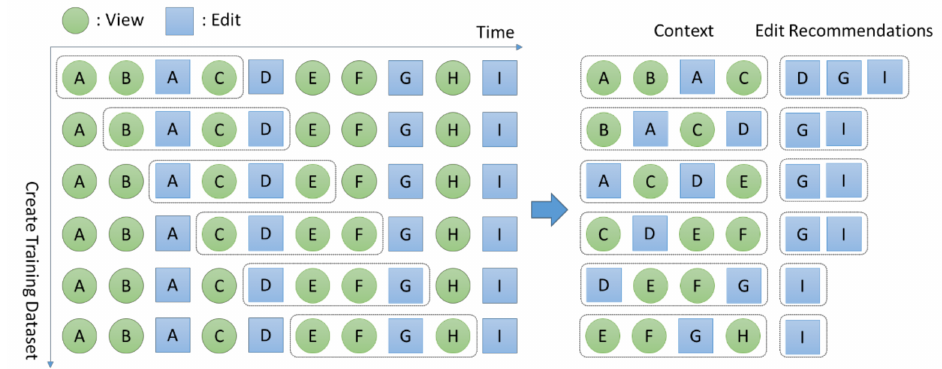
Figure 7. Sliding window method for generating training data.